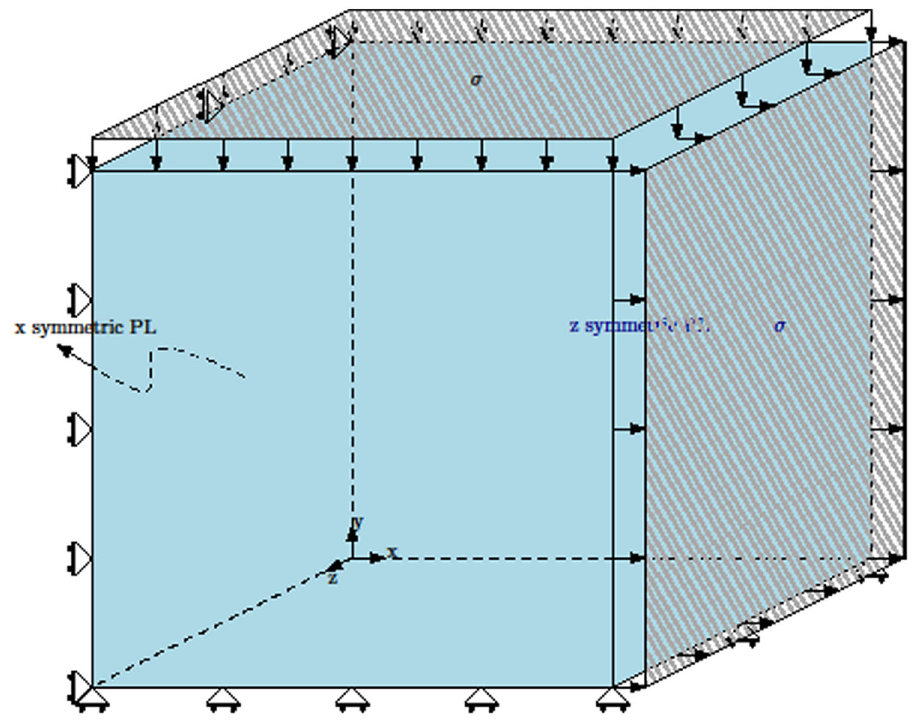
Fig. 9 Boundary and loading conditions for simple